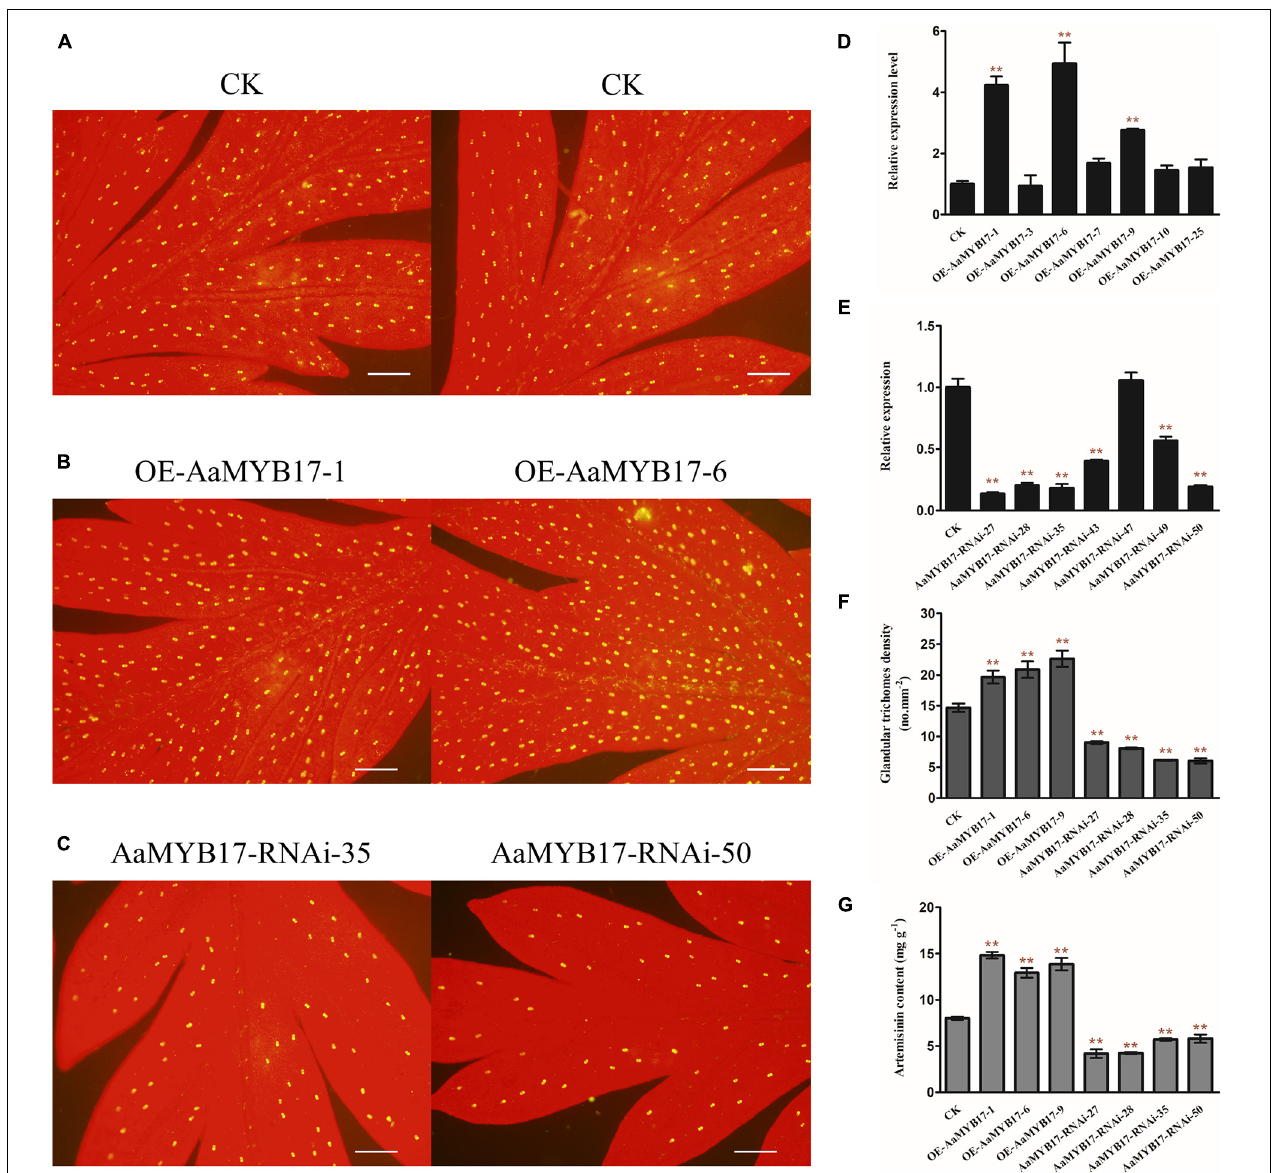
FIGURE 4 | The expression of AaMYB17 affects A. annua glandular trichome initiation. The glandular trichomes on the adaxial side of mature leaves derived from (A) wild-type (CK) plants, (B) OE - AaMYB17 transgenic A. annua plants, and (C) AaMYB17-RNAi transgenic A. annua plants (bars, 200 µ m). Expression level of AaMYB17 in the A. annua leaves in (D) OE-AaMYB17 transgenic A. annua plants and (E) AaMYB17 - RNAi transgenic A. annua plants. (F) Glandular trichomes density of mature leaves derived from CK and AaMYB17 transgenic plants. (G) High-performance liquid chromatography (HPLC) analysis of the artemisinin